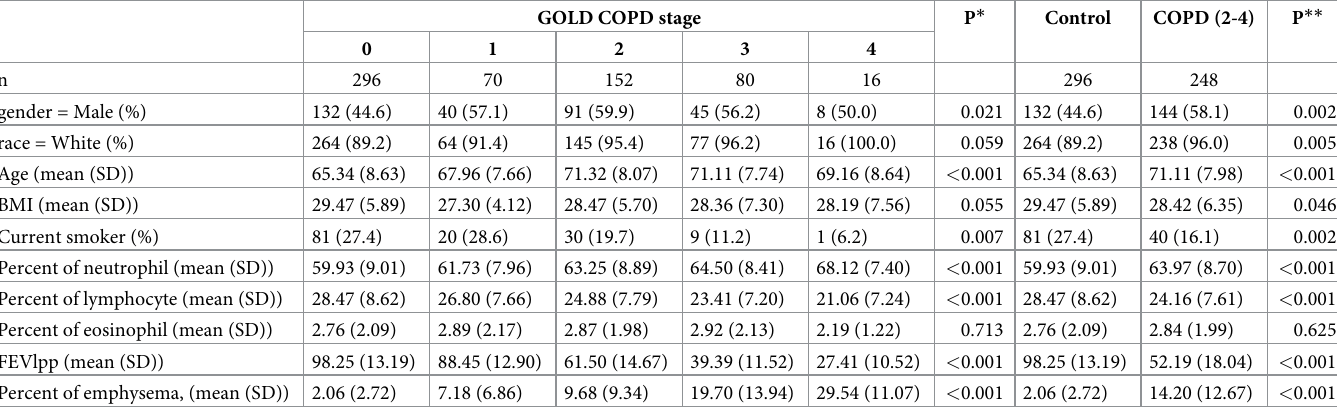
Table 1. Clinical characteristics of overlapping proteomics and transcriptomics